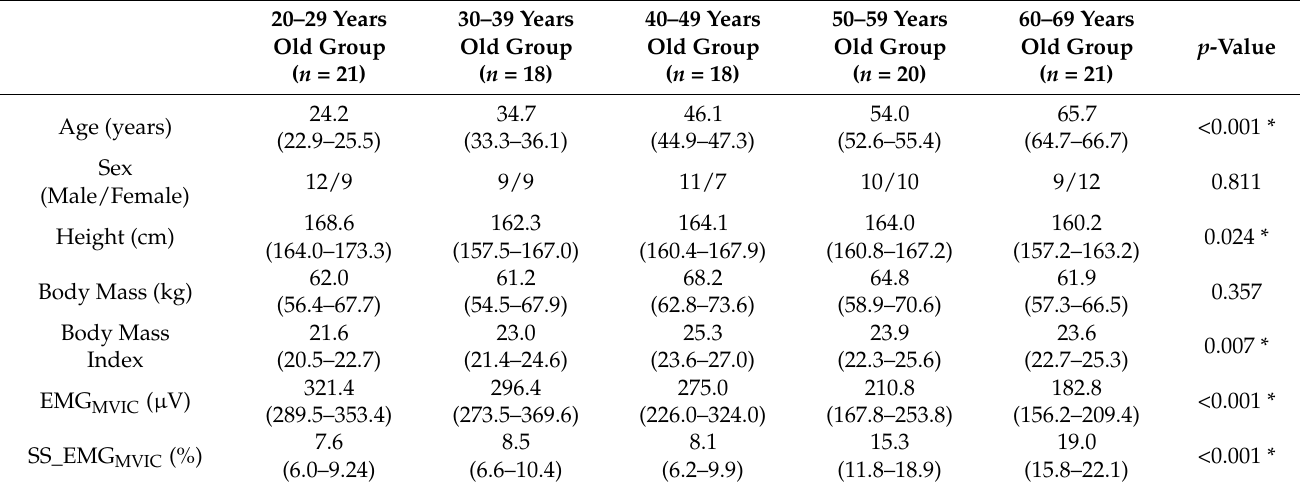
Table 1. The basic characteristics of the participants ( n = 98).